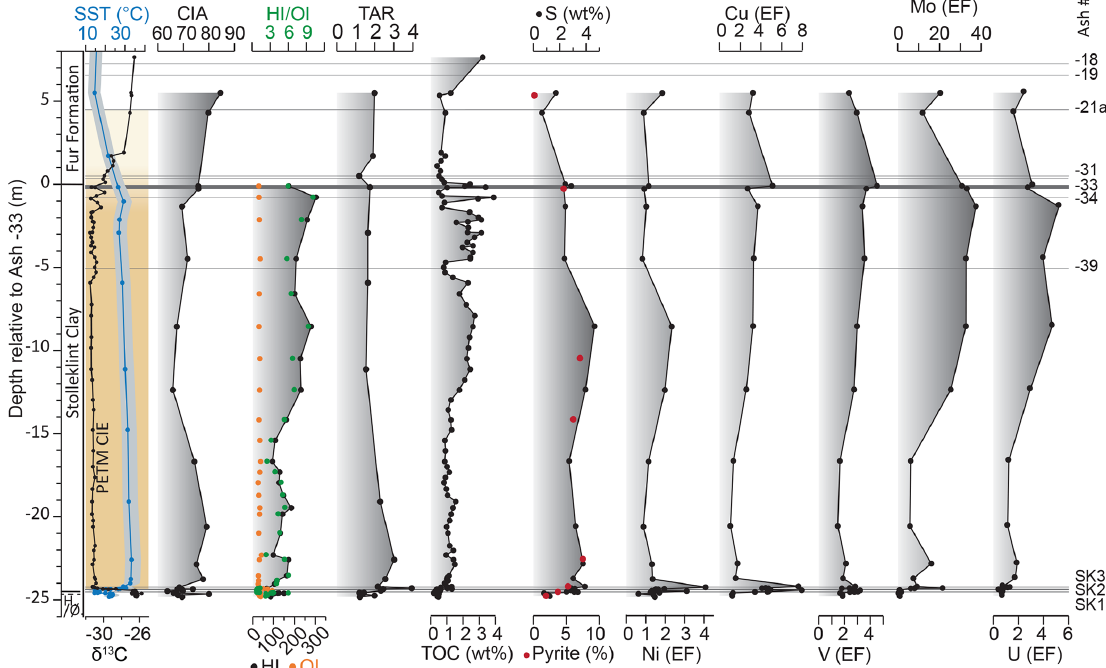
Figure 10. The section covering the whole Stolleklint PETM, with some additional samples from the nearby quarry FQ16 (Fig. 2) between − 5.6 and 2m depth. See Fig. 9 for details on each